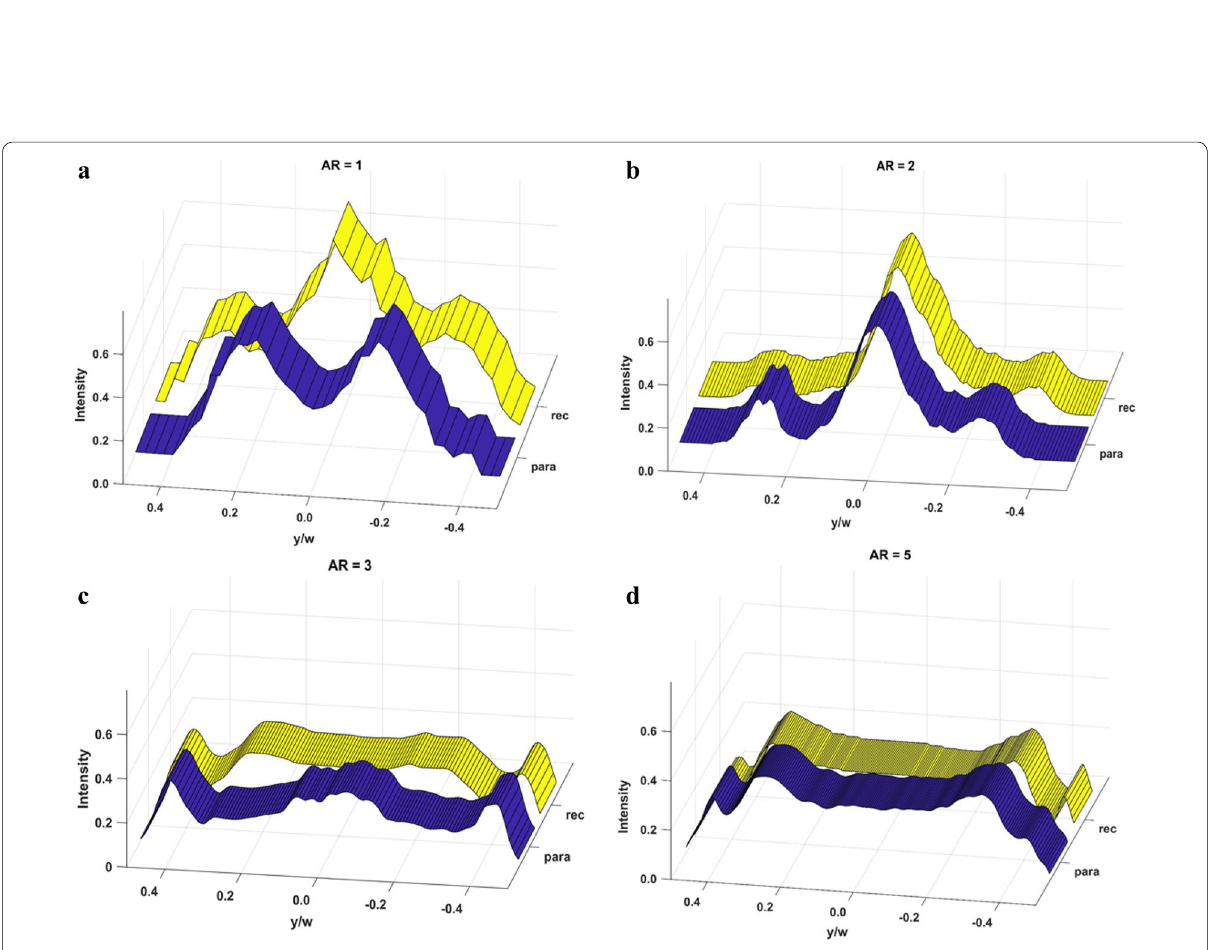
Fig. 5 Fluorescence intensities (top view) according to the particle position and cross‑section shape (yellow: rectangle, blue: parallelogram) for a AR 1, b AR 2, c AR 3, d AR = = = =